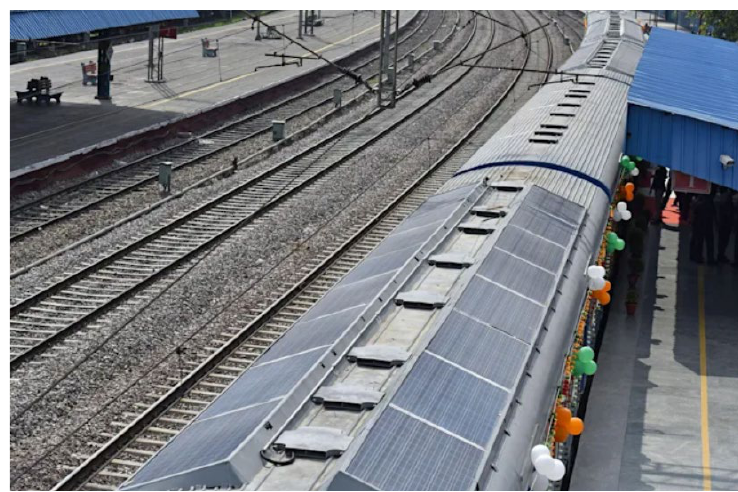
Figure 2. The UNESCO train with PV solar panels [20].